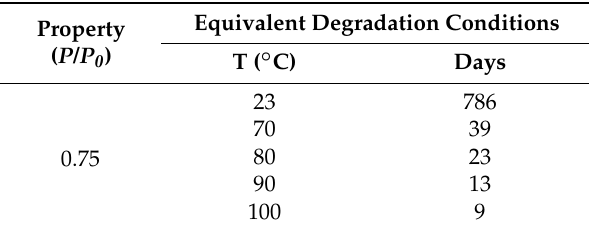
Table 4. Aging days conversion